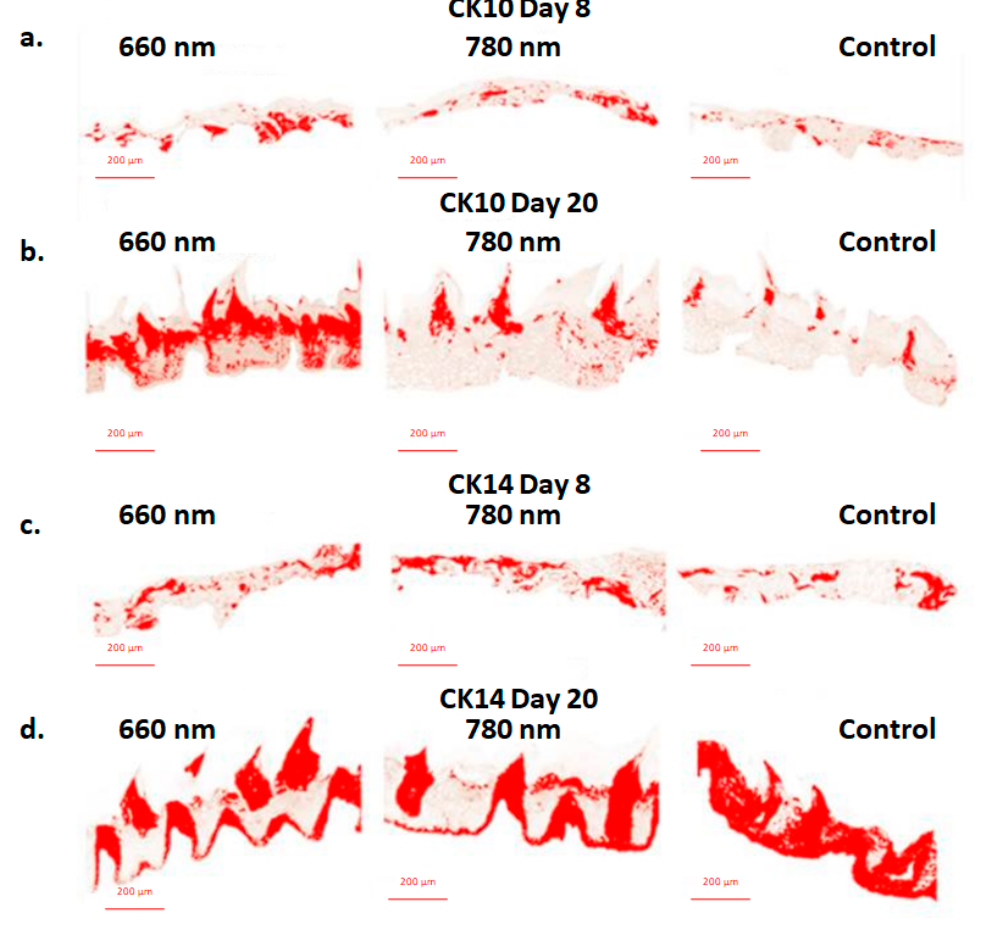
Figure 1. Photograph using the NIS-Elements Advanced Research software AR 4.50.00 (build 1117) Patch 01 64 bit (40 × , by optical microscopy (Nikon Eclipse Ti-E, Shinagawa, Japan) and highlighting the area marked by the IHQ, by the Colour Deconvolution 2 ® plugin on the ImageJ ® program. ( a ) CK10 on day 8; ( b ) CK10 on day 20; ( c ) CK14 on day 8; ( d ) CK14 on day 20: note the difference in the distribution pattern of CK14 in the 20-day control group compared to PBMT groups from the same